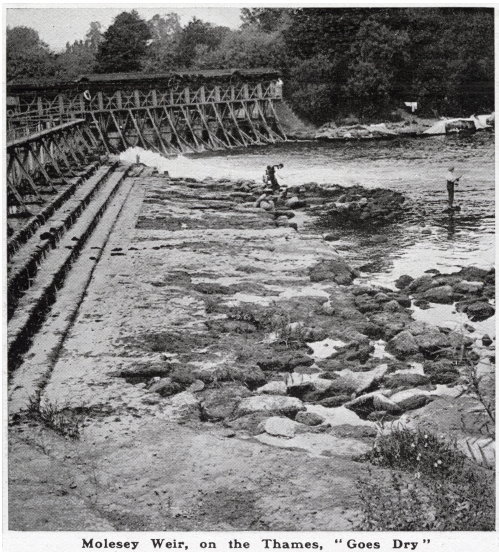
Figure A7. Photograph from the British illustrated newspaper The Sphere , 20 August 1921. The original caption is “Molesey Weir, on the Thames, ’Goes Dry’. This picture gives a most vivid presentation of one of the effects of the drought. Molesey Weir, usually noted for its rush of water, is here seen almost perfectly free from water – a sight very rarely seen even by the oldest inhabitants”. Copyright: Illustrated London News Ltd/Mary Evans.